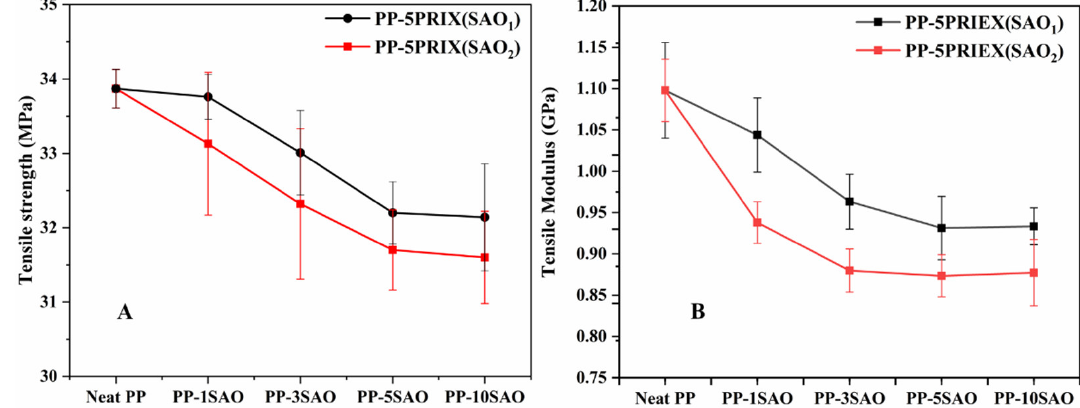
Figure 3. The tensile strength ( A ) and tensile modulus ( B ) of PP/PRIEX / SAO 1 and PP/PRIEX / SAO 2 .